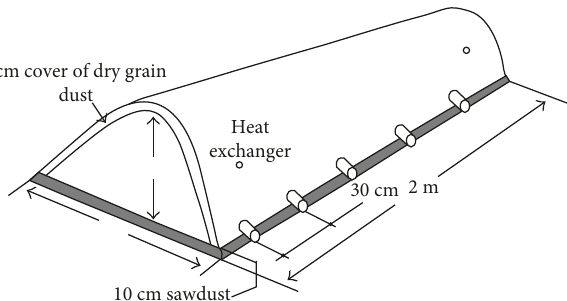
Figure 2: A schematic of the compost pile of olive cake used in this work [20].